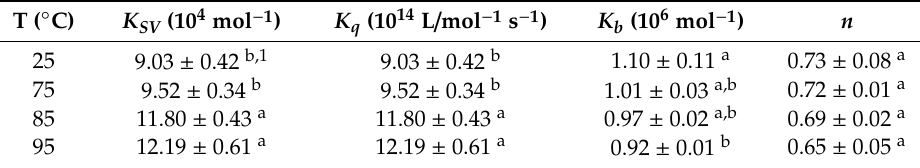
Table 2. The binding parameters of the fish waste low molecular weight peptides heat treated at di ff erent temperatures by flavonoids extracts from yellow onions skins.